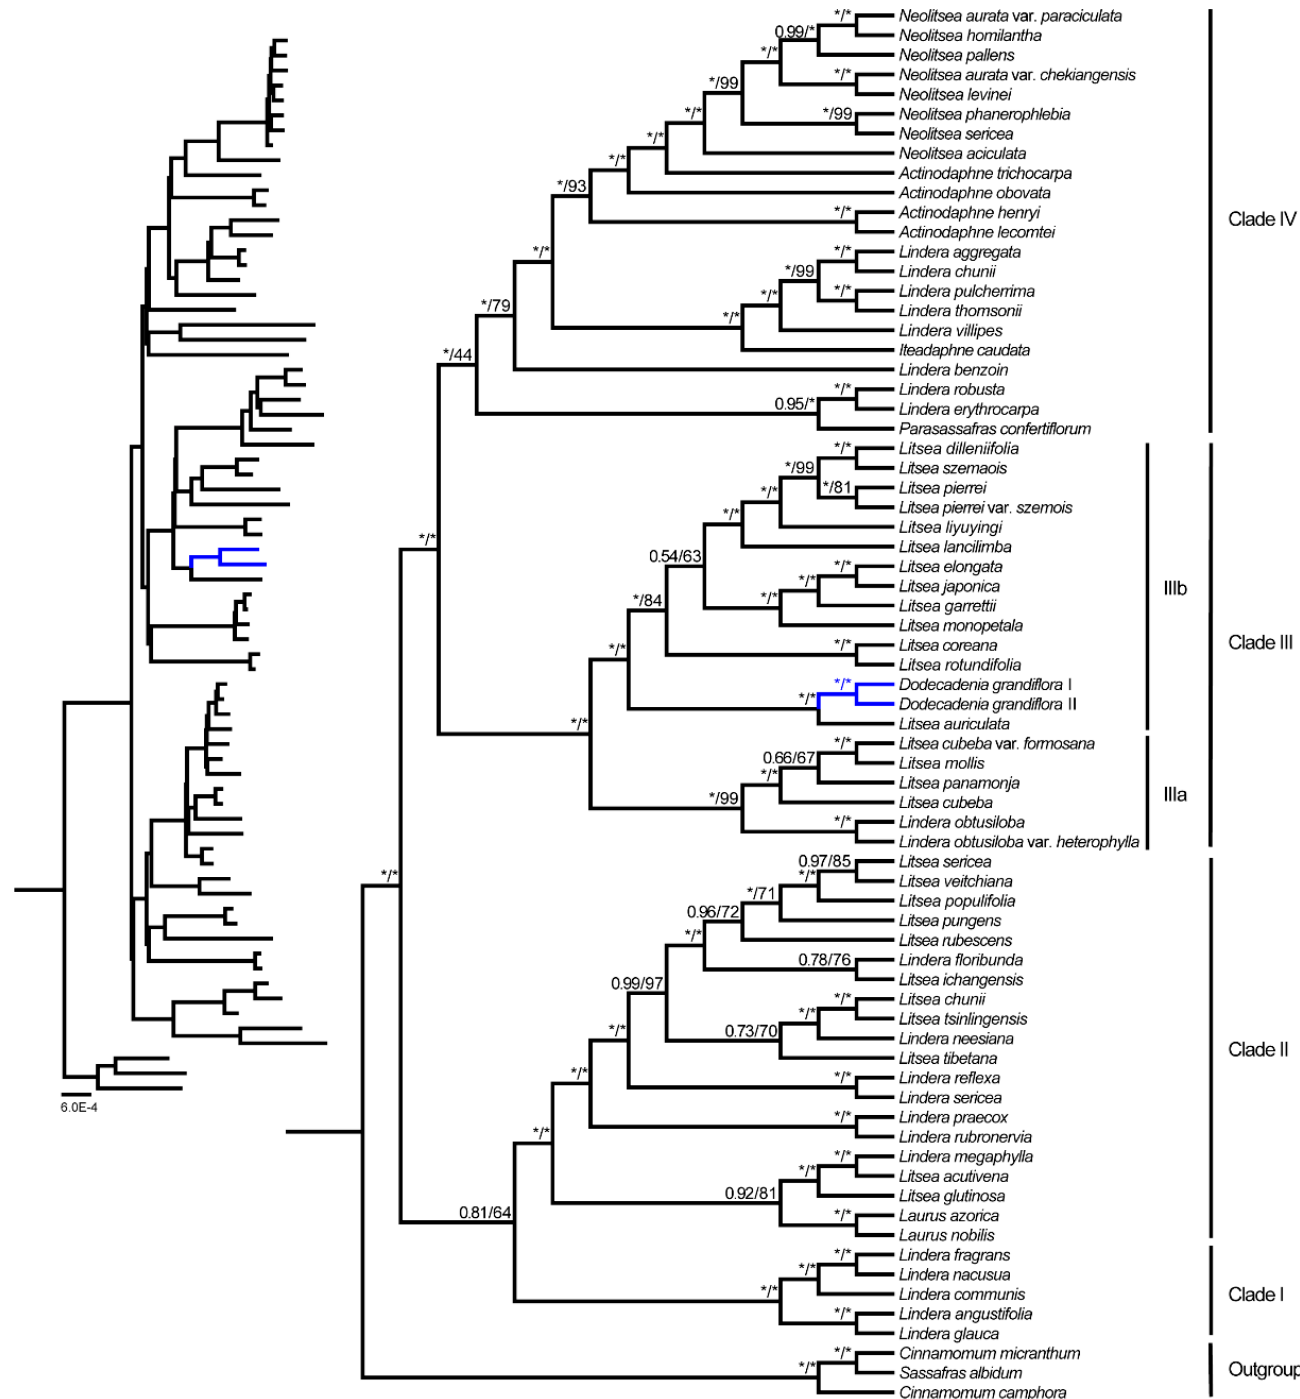
Figure 6. Complete plastome phylogenetic tree of Litsea complex inferred from Bayesian inference and maximum likelihood analysis. The support values (Bayesian inference/bootstrap value) are indicated at the branches. The star represents the value 1 or 100.